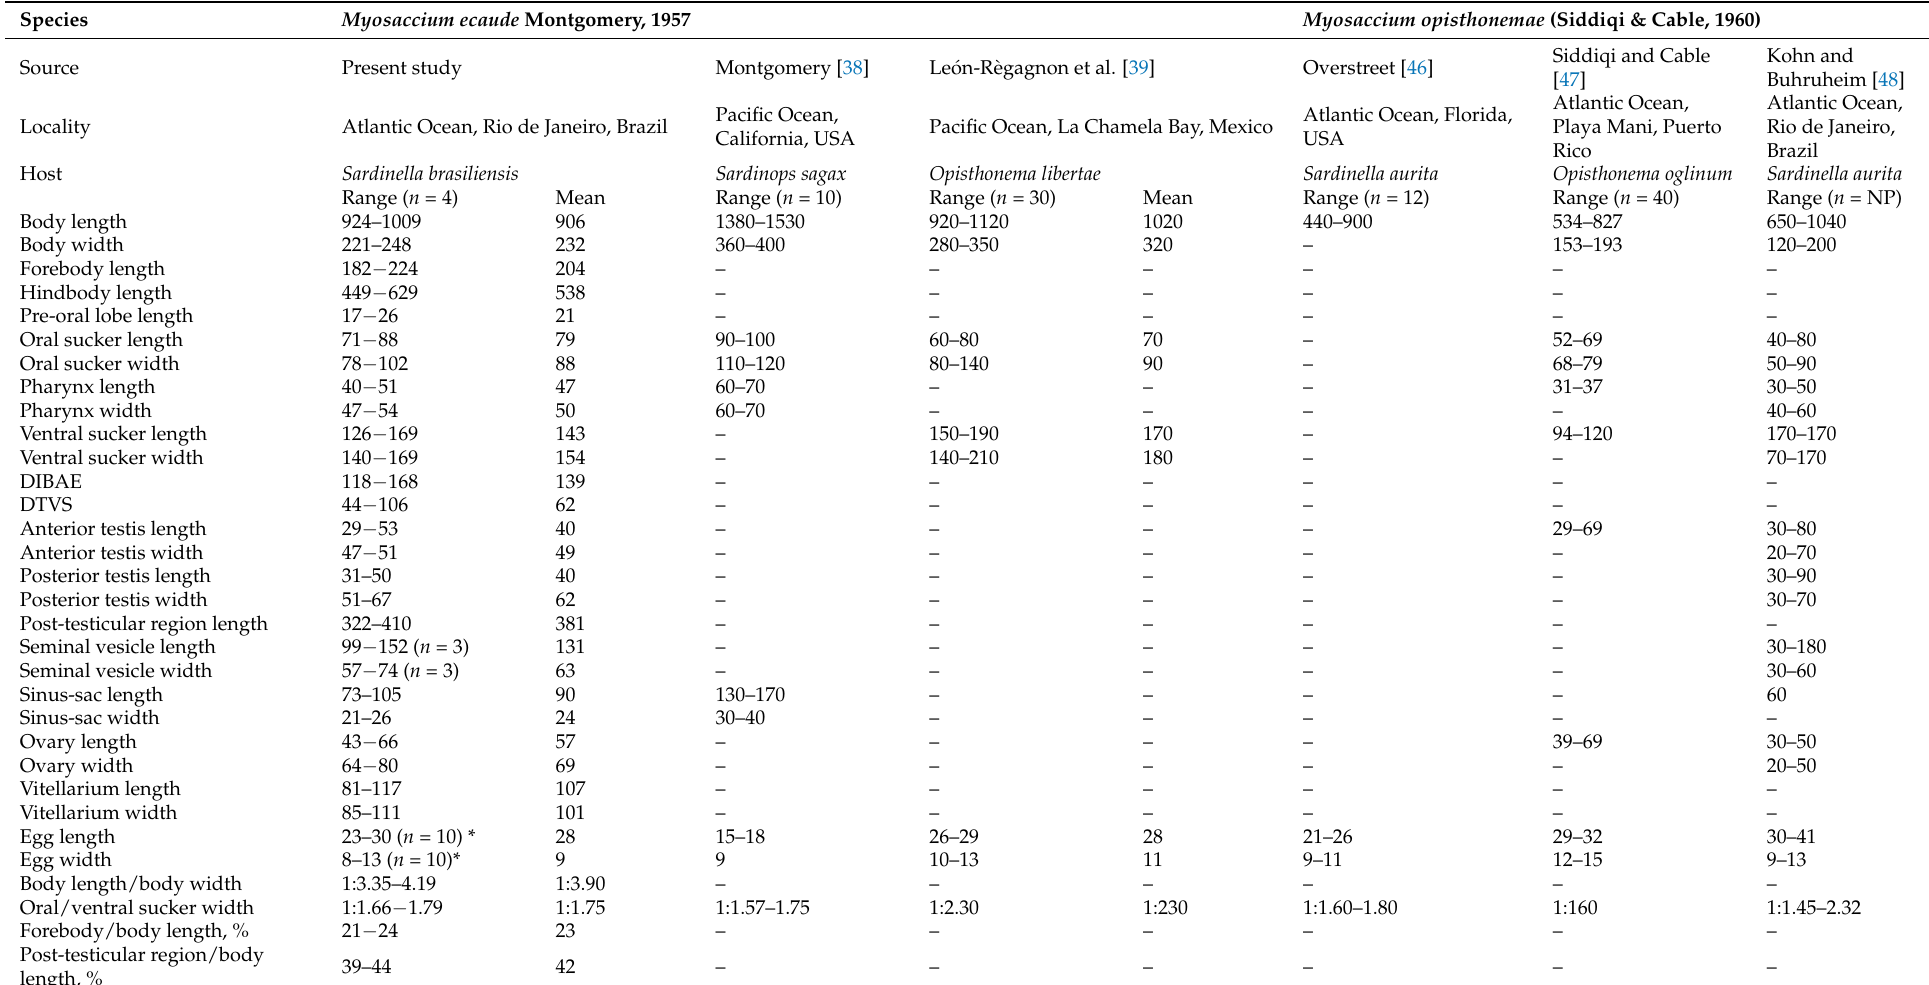
Table 1. Comparative metrical data of Myosaccium